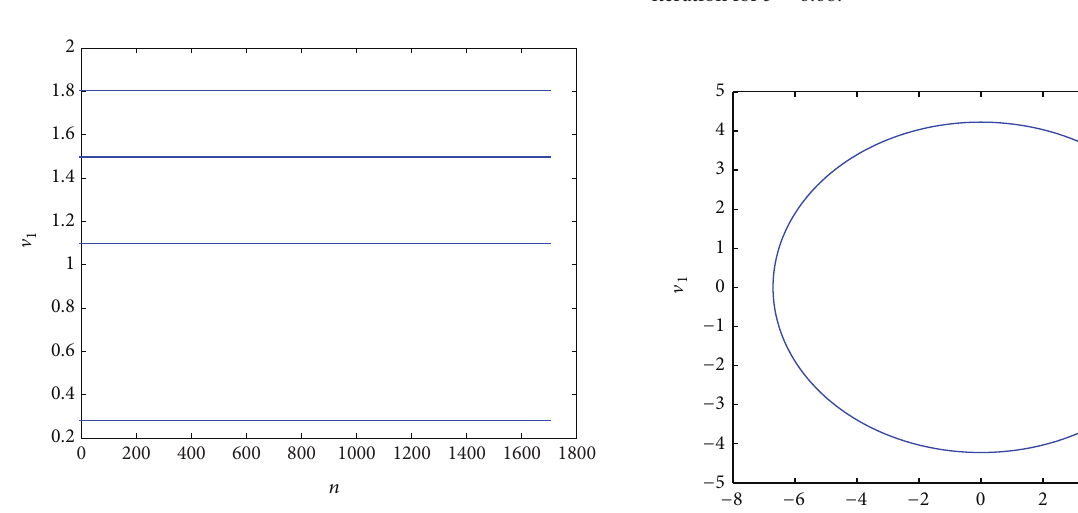
Figure 8: The velocity of the oscillator 𝑀 1 versus the number of iteration for 𝑏 = 6.68 .